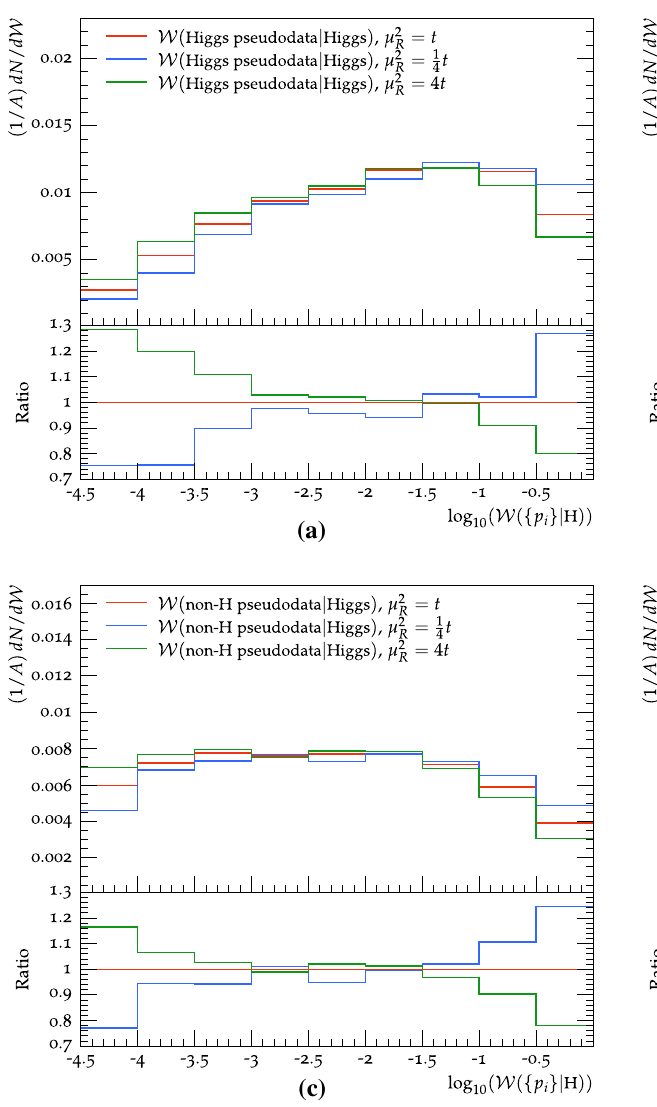
different values for the argument of the QCD running coupling, both in the evaluation of coupling factors as well as the evaluation of no-branching probabilities